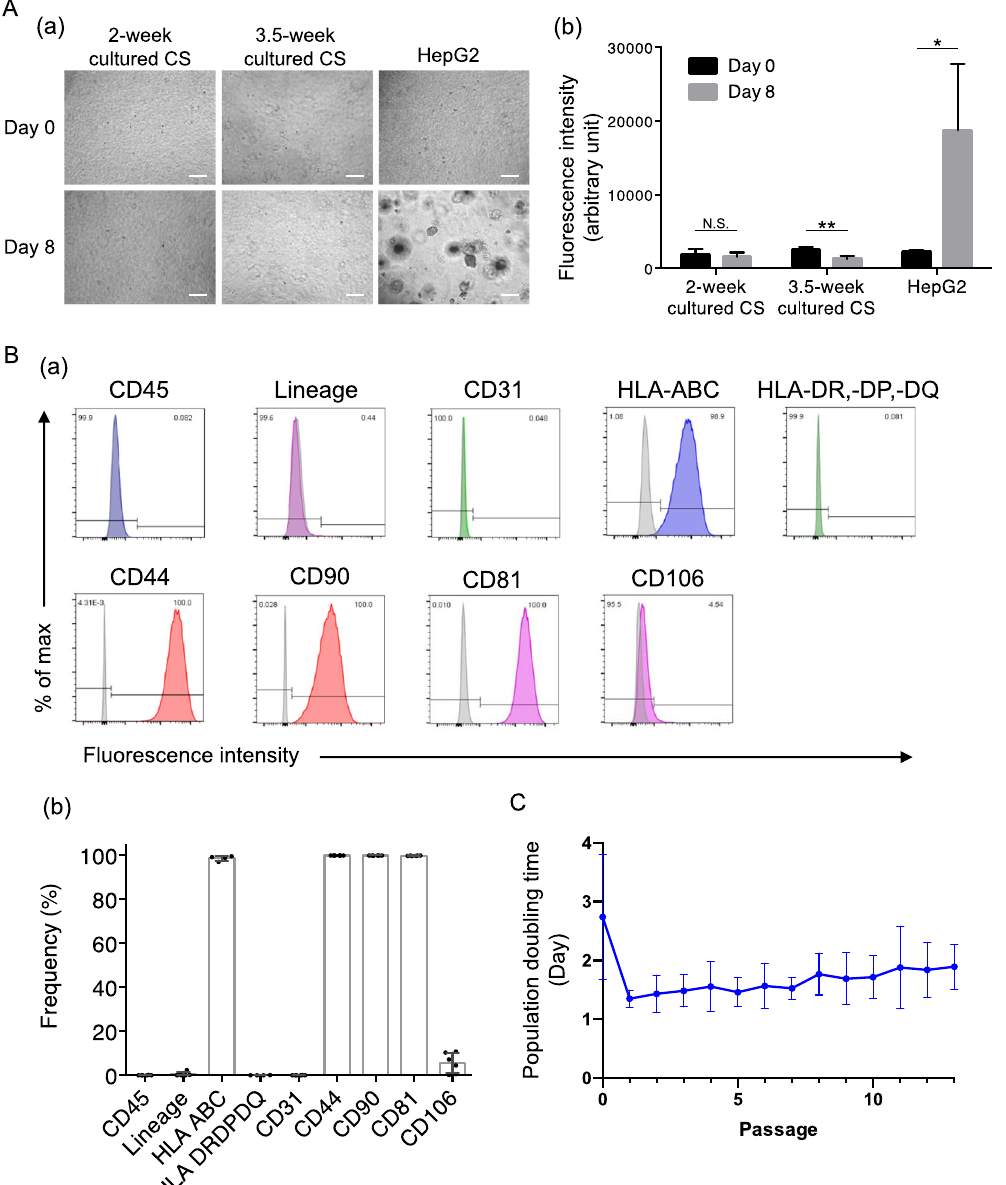
Fig. 3 Tumorigenicity assay, population doubling time, and cell surface markers. A (a) Microscopic images of in vitro tumorigenicity assay in soft agar culture conditions. Images of the left column show seeded cells from 2-week cultured cell sheet. Images of the middle column show seeded cells from 3.5-week cultured cell sheet. Images of the right column show seeded HepG2 cells as a positive control. The top row shows the image at day 0 and the bottom shows images at day 8 after seeding. Bars: 200 µm. (b) Semi-quanti fi cation of cell number by DNA- bound fl uorescence in soft agar culture at day 0 and day 8. Data shown as mean and SD ( n = 4 individual donors). ** p < 0.01, * p < 0.05, N.S. (non-signi fi cant) by Student ’ t test. B Flow cytometry analysis for cell purity and surface marker characterization. (a) Representative histograms for CD45, lineage cocktail (mixture of CD3, CD14, CD16, CD19, CD20, CD56), CD31, HLA-ABC, and HLA-DR, -DP, -DQ, CD44, CD90, CD81, and CD106. Column colors represent fl uorophores (blue: Paci fi c blue, green: FITC or Alx488, red: PE, magenta: APC or Alx647) (b) Average percentages for CD45, lineage cocktail (mixture of CD3, CD14, CD16, CD19, CD20, CD56), CD31, HLA-ABC and HLA-DR, -DP, -DQ, CD44, CD90, CD81, and CD106. n = 4 – 6 individual donors. C Population doubling time in the extended subculture in chondrocyte culture medium up to P13. Data shown as mean and SD ( n = 13 individual